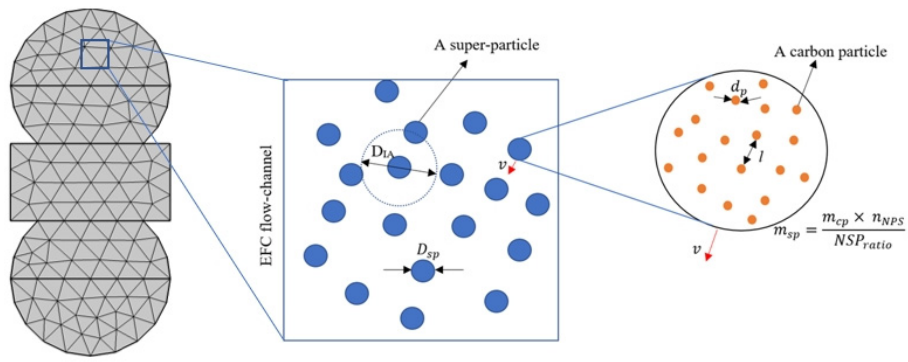
Figure 3. Schematics of carbon particles and the SP system for parameters representation (not to scale).